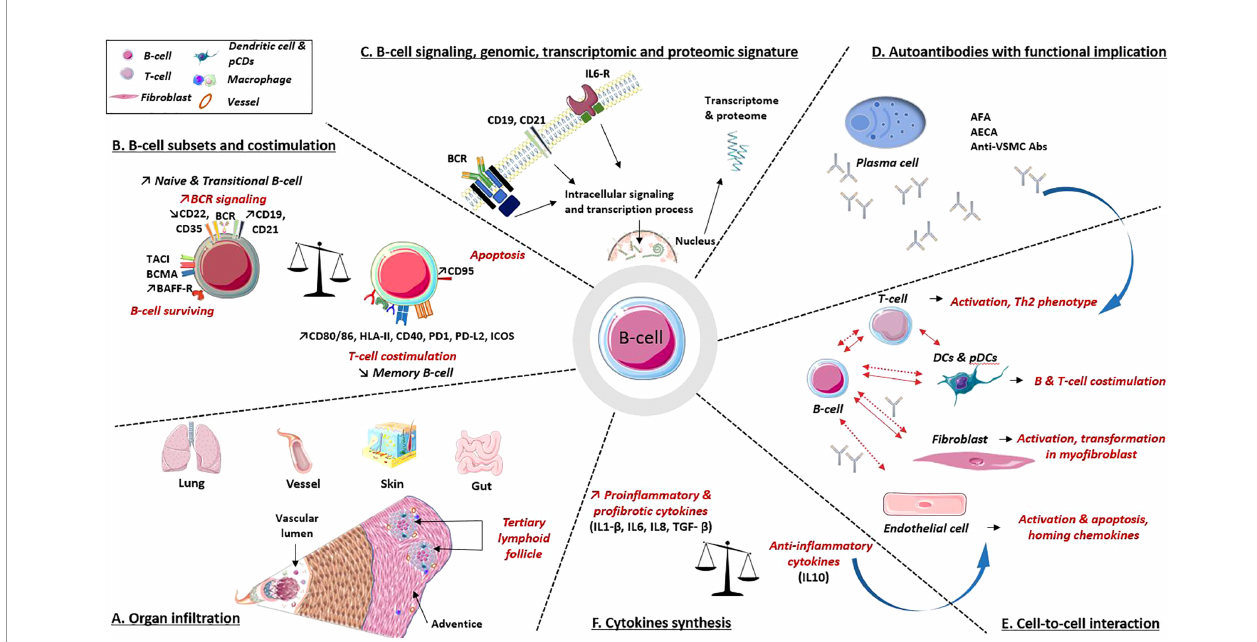
FIGURE 3 | B-cell implications in the pathogenic processes involved in systemic sclerosis. (A) Organ in fi ltration: B-cell in fi ltrates are present in various organs involved in SSc. These in fi ltrates combine B and T cells, plasma cells, dendritic cells and macrophages, underlying their interactions. (B) B-cell subpopulations: B-cells express at their surfaces multiple molecules involved in activation or surviving pathway, as well as decreased levels of inhibitors coreceptors. B-cells also express co-receptors required for interaction with T cell. (C) B-cell intracellular signaling, genomic, transcriptomic and proteomic data argue a B-cell signature in SSc. (D) Autoantibodies. Several autoantibodies have demonstrated their involvement in cell activation, apoptosis induction, proin fl ammatory and pro fi brotic processes. (E, F) Cell to cell interactions and cytokines synthesis: B-cells interact with various immune cells, fi broblast and endothelial cell through direct (solid line) and indirect contact (i.e., cytokines and antibodies; dotted line). All participate in pro fi brotic, proin fl ammatory processes, vascular remodeling and immune dysregulations. Abs, antibodies; AECA, anti-endothelial cell Abs; AFA, anti- fi broblast Abs; anti-VSMC Abs, anti-vascular smooth muscle cell Abs; BAFF-R, calcium-modulator and cyclophilin ligand-interactor and BAFF receptor; BCMA, B-cell survival membrane receptors: B-cell maturation protein; BCR, B-cell receptor; CD, cluster of differentiation; DCs, dendritic cells; HLA-II, human leukocyte antigen class II; ICOS, inducible T-cell costimulatory; IL, interleukin; IL6-R, IL6 receptorPD-1/PD-L2: programmed death/programmed death ligand immune checkpoint; pDCs, plasmacytoid dendritic cells; TACI, trans-membrane